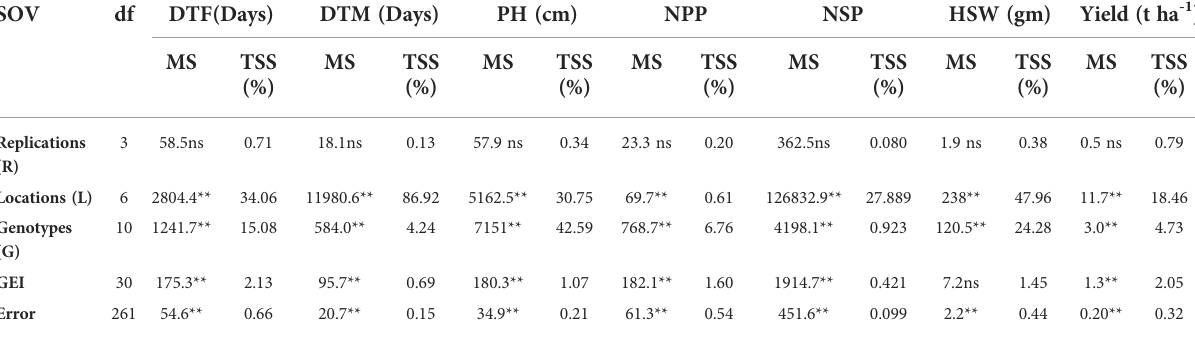
TABLE 3 Estimation of signi fi cant level for yield and yield contributed traits for eleven soybean genotypes revealed by ANOVA.